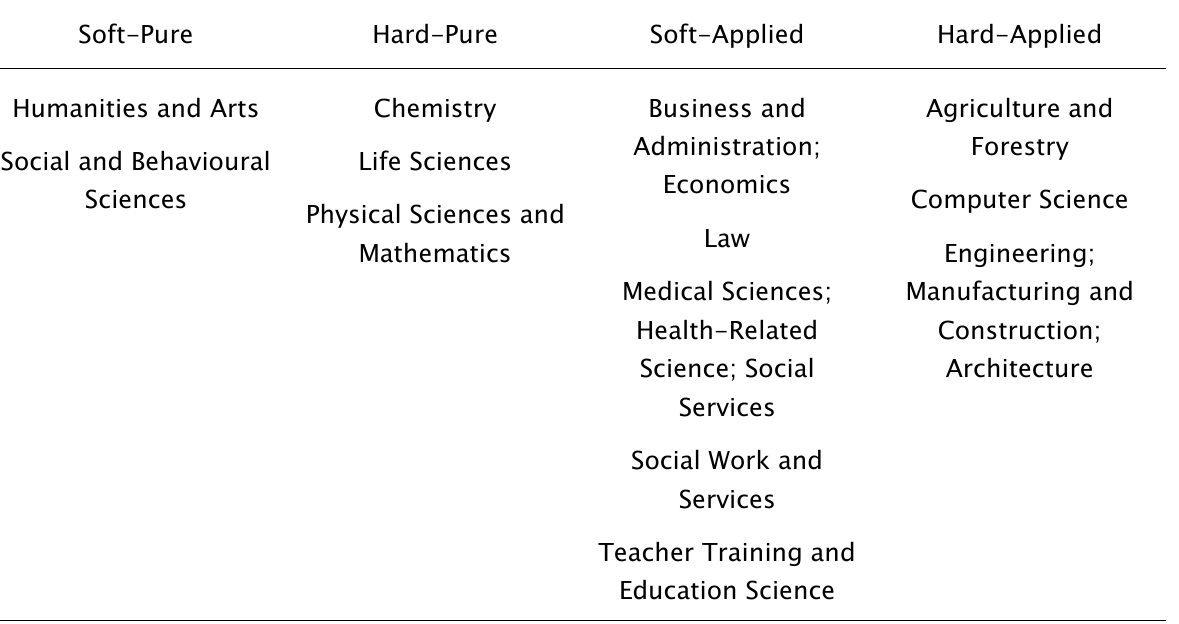
Like-Groups of Disciplines as per Biglan